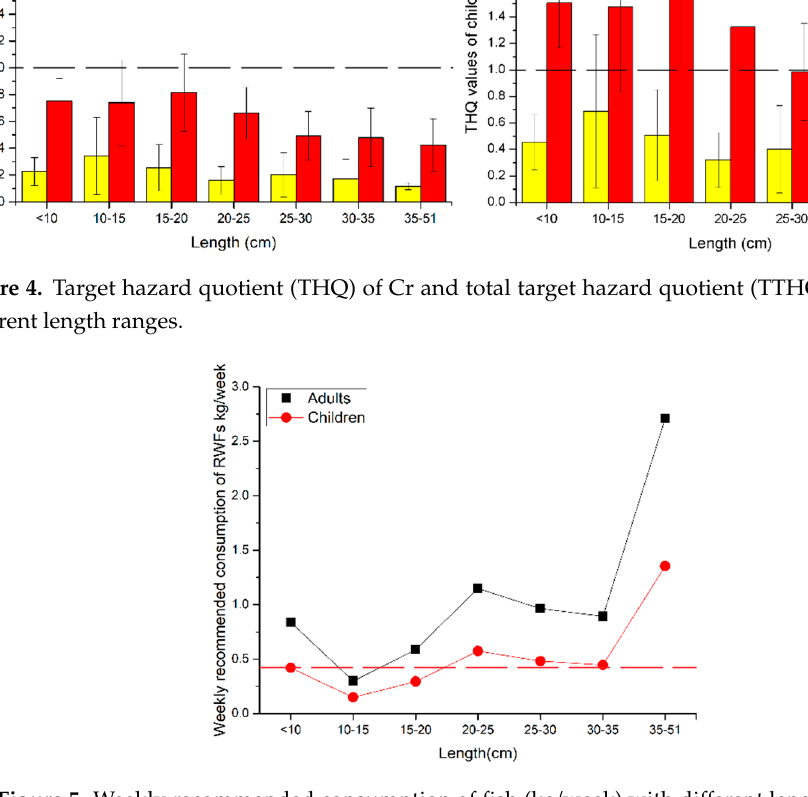
Figure 5. Weekly recommended consumption of fish (kg/week) with different length ranges.